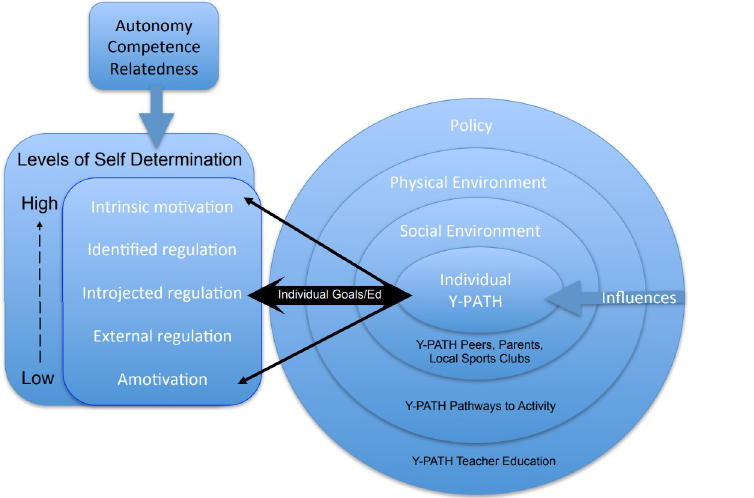
Fig 2. Theoretical framework of the Y-PATH